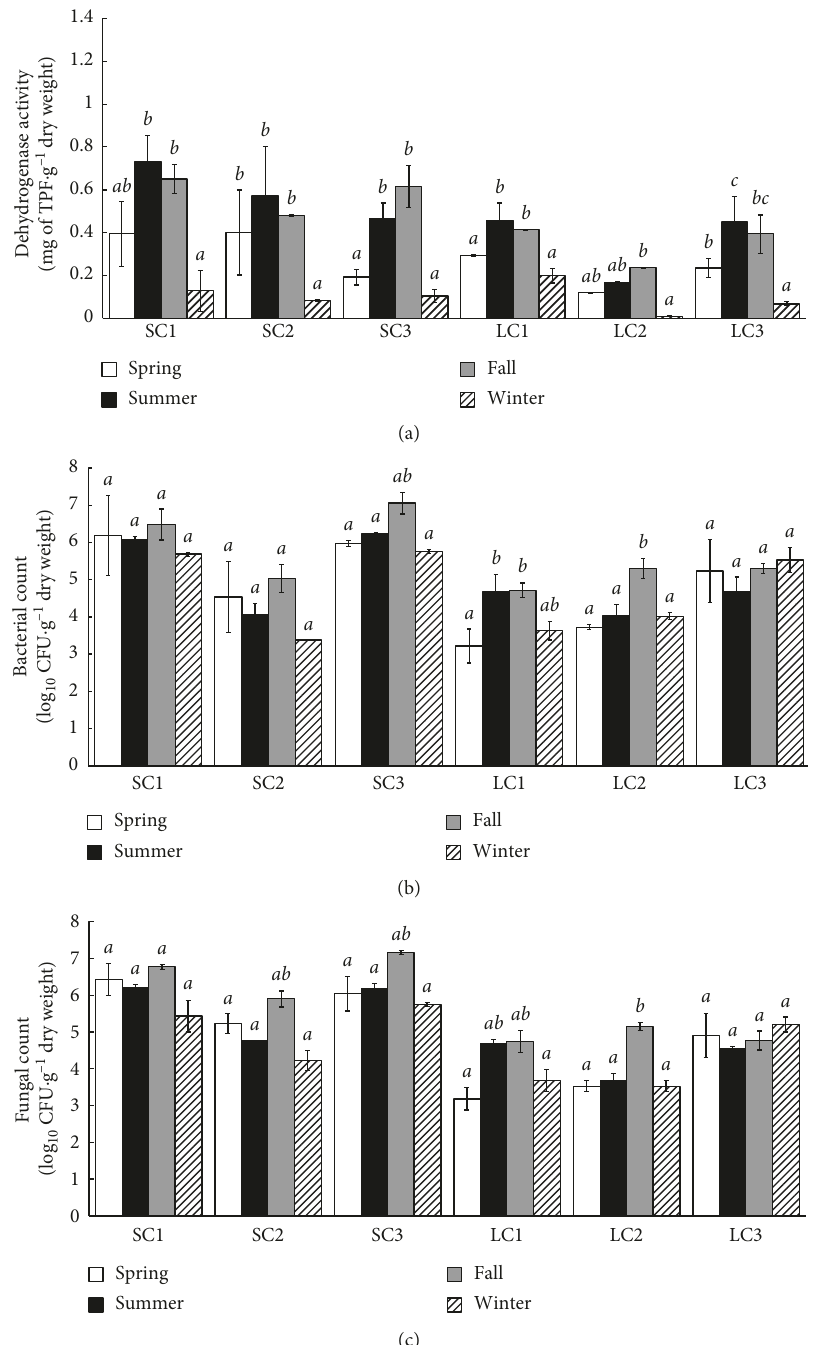
Figure 3: Dehydrogenase activities (a) and bacterial (b) and fungal (c) numbers of the river and lake sediments across different sites and